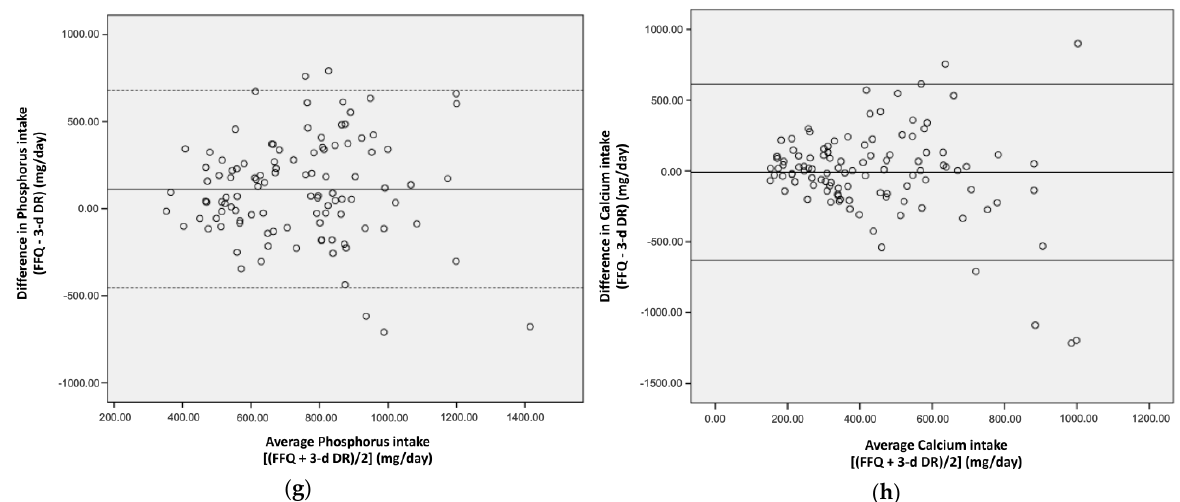
Figure 1. Bland – Altman plots demonstrating degree of agreement between the two assessment tools for daily intakes of ( a ) energy, ( b ) protein, ( c ) fat, ( d ) carbohydrate, ( e ) fiber, ( f ) potassium, ( g ) phosphorus, and ( h ) calcium in Taiwanese patients with chronic kidney disease (CKD). Solid lines indicate differences, and dashed lines indicate lower and upper limits (95%) of agreement.